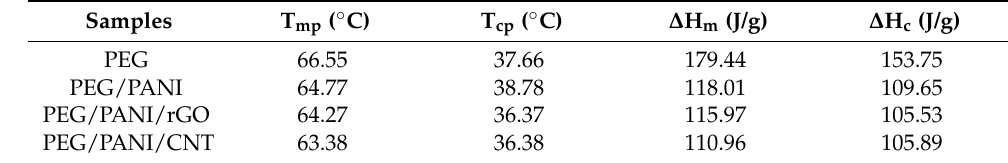
Figure 5. DSC results for the pure PEG and PEG/PANI composites filled with ( A ) rGO and ( B ) CNT. Table 1. DSC characteristics of the pure PEG and PEG composites.